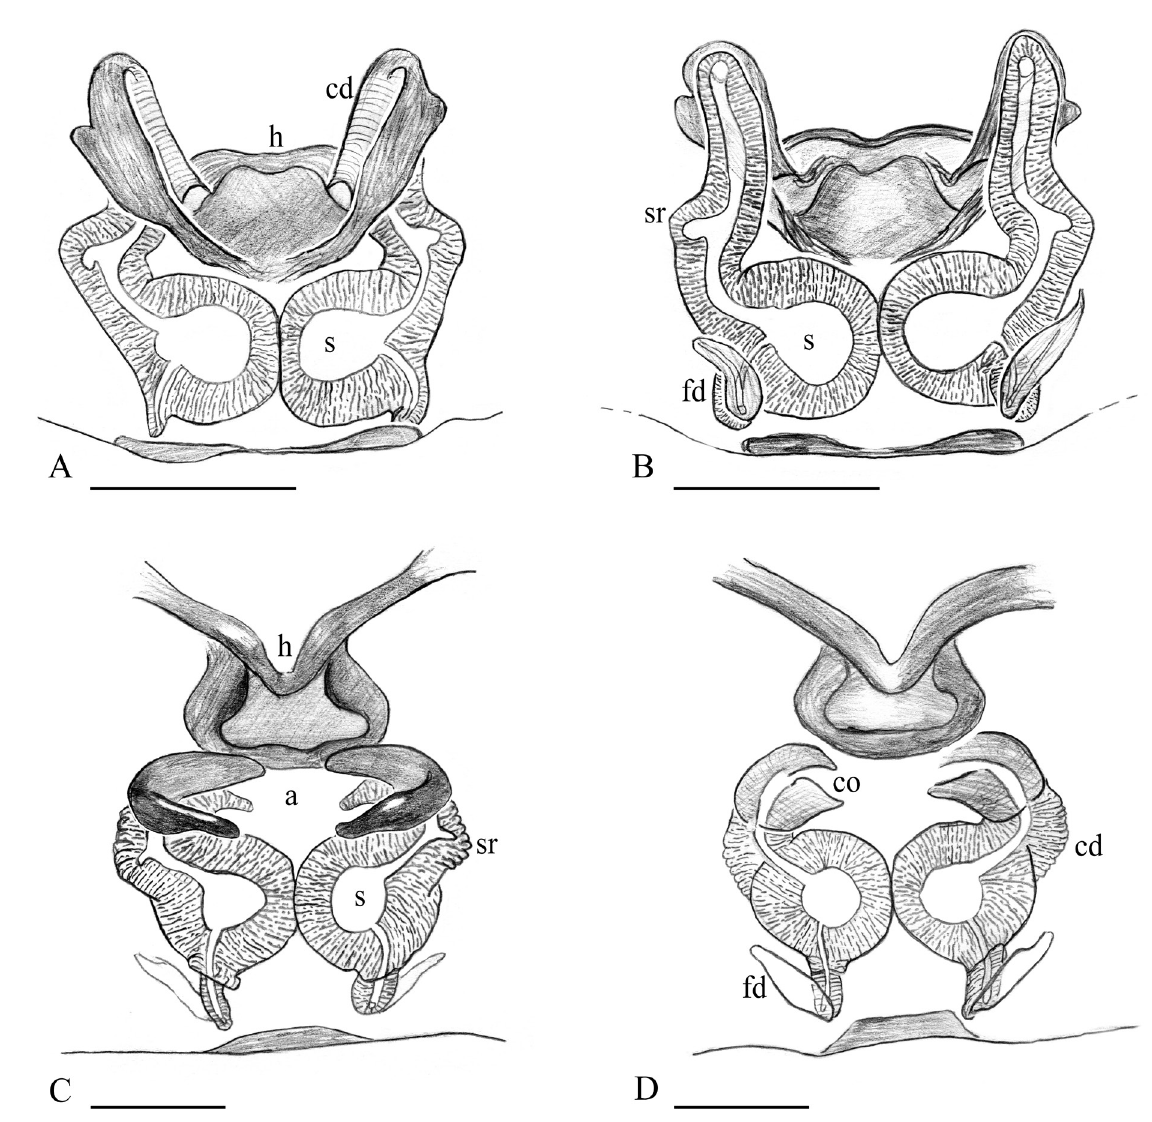
Fig. 38. Anyphaena spp. A–B . A. sofiae sp. nov., paratype, ♀ (CNAN-T01572). A . Epigynum, ventral view. B . Epigynum, dorsal view. – C–D . A. noctua sp. nov., holotype, ♀ (CNAN-T01533). C . Epigynum, ventral view. D . Epigynum, dorsal view. Scale bars: A– B = 0.2 mm: C–D = 0.1